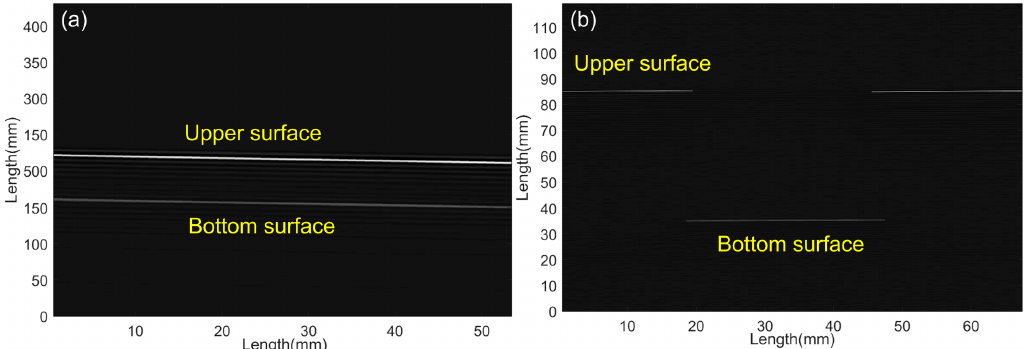
Figure 8. Images of physical models: ( a ) tilt rectangular bulk; ( b ) rectangular hole in a bulk.